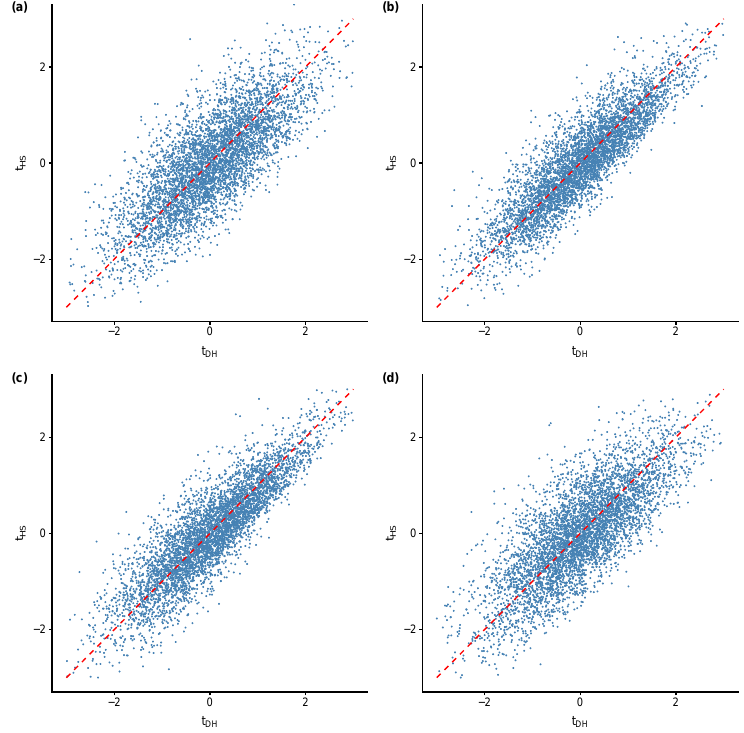
Figure 1. Pairs of probits for empirical p -values under an early negative variance break: N = 10 and T = 100. M = 5000 replications. ( a ) Cross-sectional independence; ( b ) spatial correlation, Θ = 0.8; ( c ) equicorrelation, ω = 0.5; and ( d ) single common factor, v t ∼ iid N ( 0,1 ) , η i ∼ iid U ( 0,0.02 )